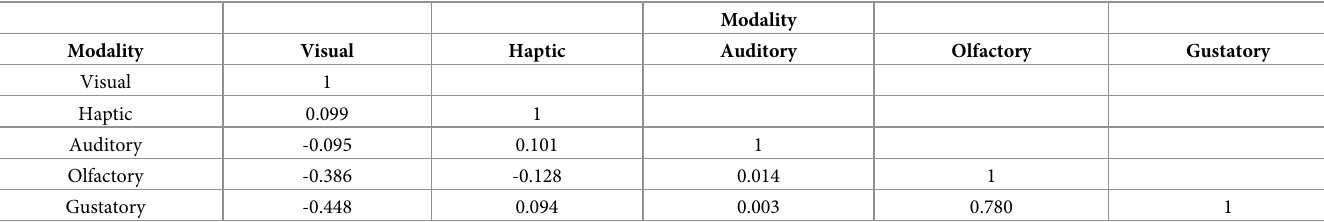
Table 3. Correlation matrix for mean strength ratings on the five perceptual modalities in Mandarin.